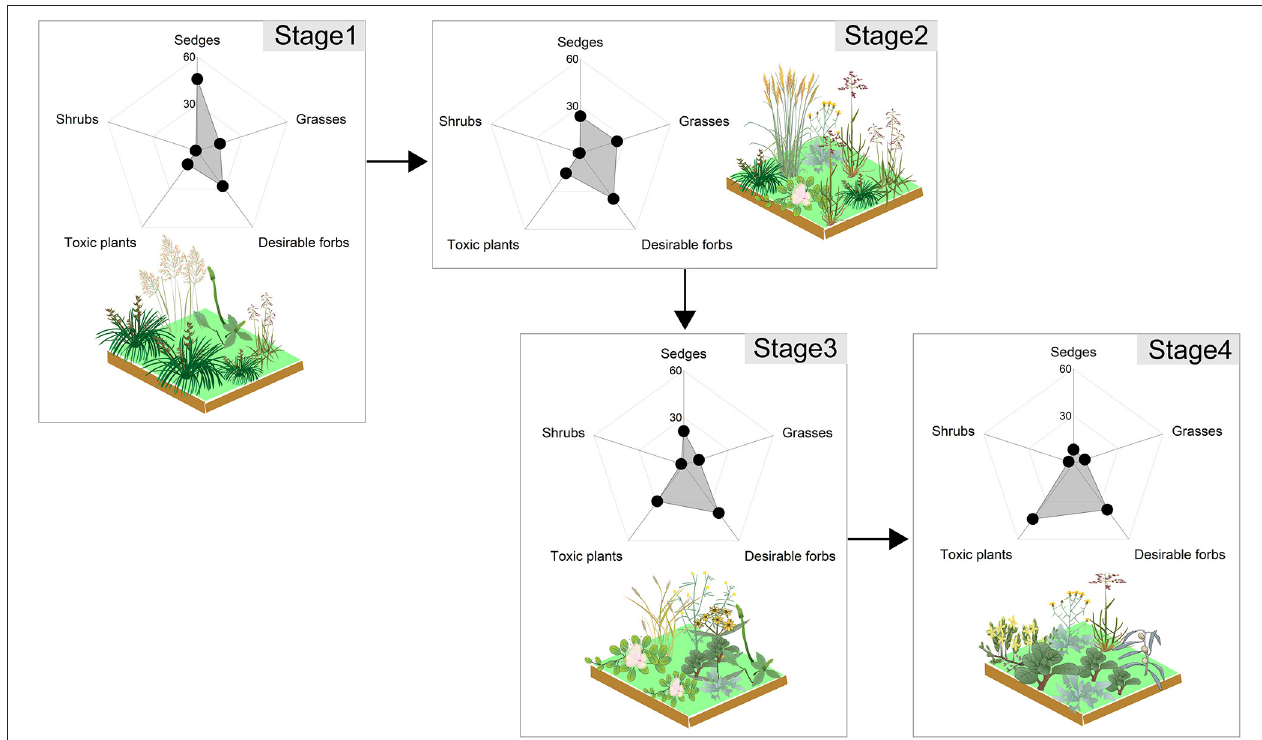
FIGURE 1 | The plant community succession of an alpine meadow of the Tibetan Plateau as a result of grazing. Dominant sedge genera included Kobresia and Carex ; dominant grass genera included Elymus and Poa ; dominant desirable forb genera included Saussurea and Potentilla ; dominant toxic plant genera included Gentianaceae , Ranunculaceae , and Euphorbiaceae ; and dominant shrub species consisted of Berberis wilsonii and Potentilla fruticosa